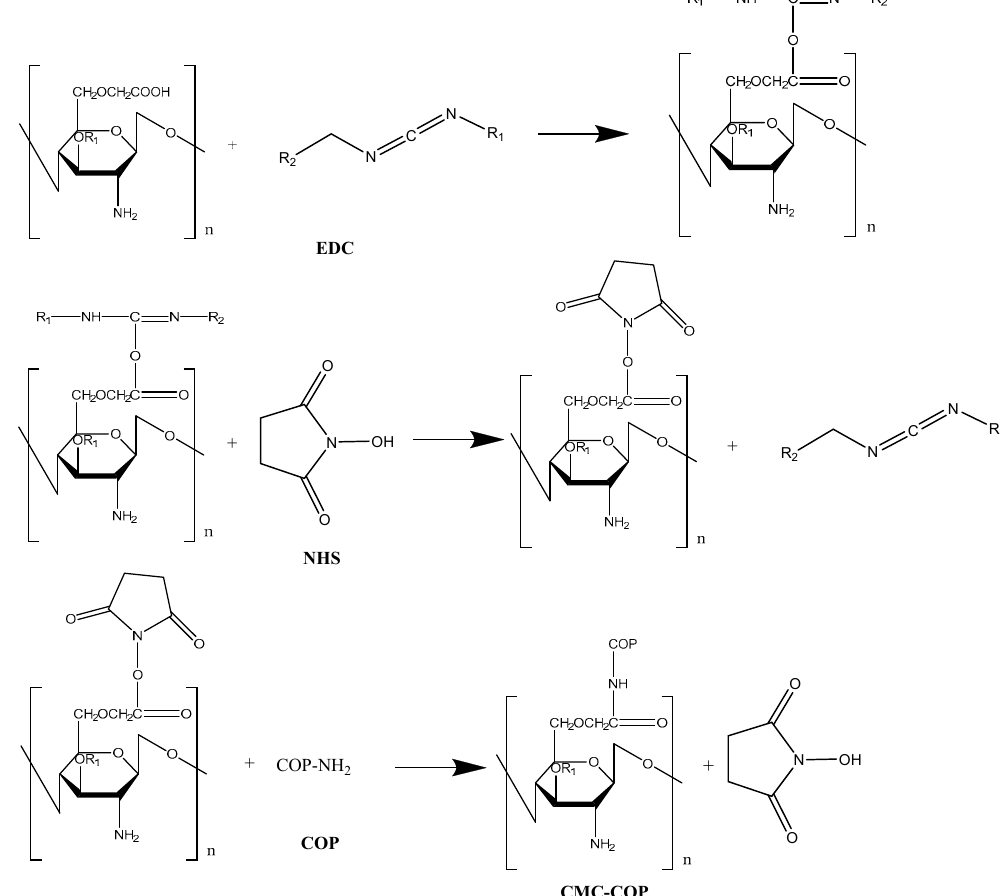
Figure 1. Mechanism of carboxymethyl chitosan grafted with collagen peptide. Carboxymethyl chitosan sponges grafted with collagen peptides (CMC–COP); NHS, N-hydroxysuccinimide.